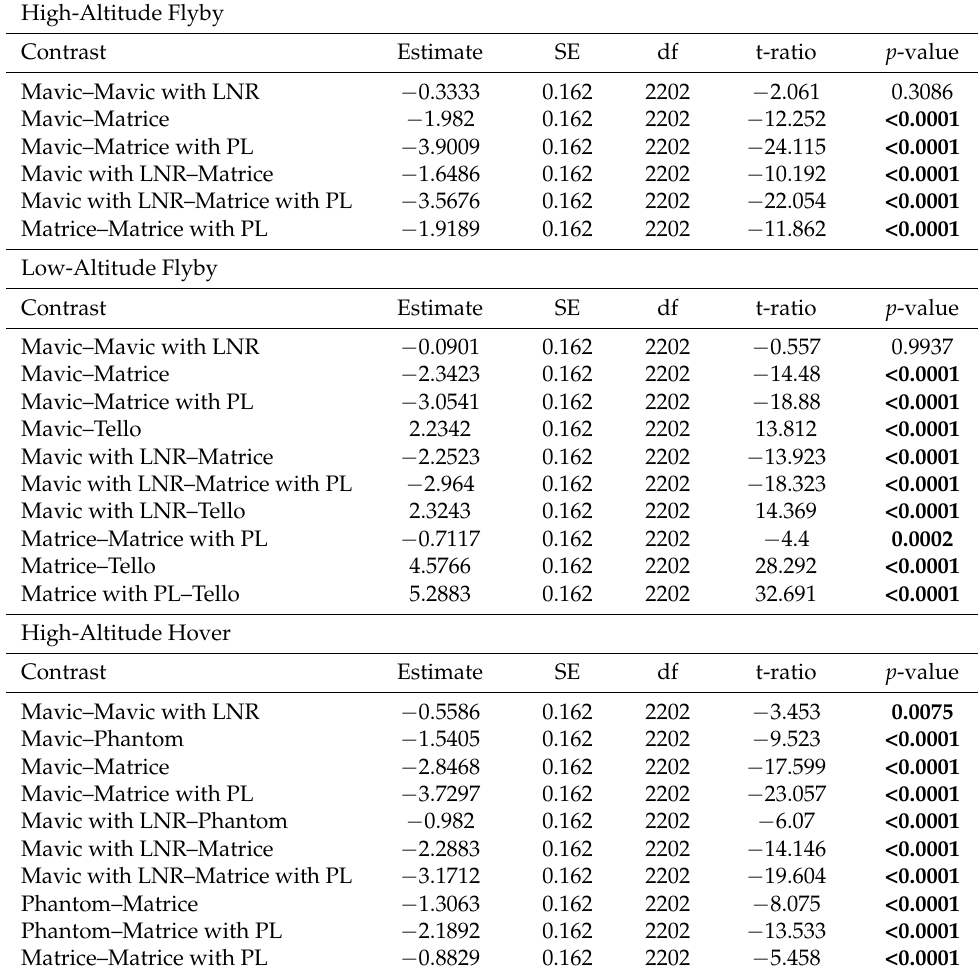
Table A2. Pairwise contrasts of the annoyance ratings between UAV types. p -values in bold represent statistical significance